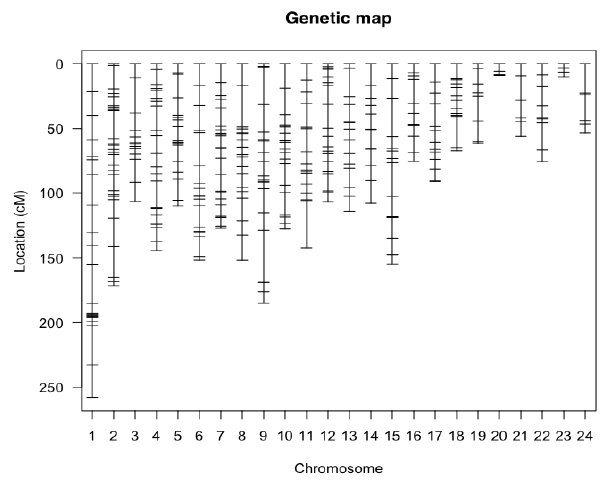
Figure 1. Genetic map of Cucurbita moschata. R / qtl analysis generated 24 linkage groups based on genotype-by-sequencing (GBS) data from ‘Shima’X [‘Shima’ X ‘Taina Dorada’] population. Of the 1582 MCR50 SNPs, 711 were used to generate the genetic map.